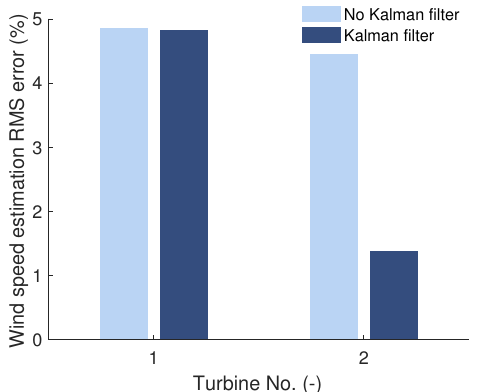
Figure 5. Root-mean-square (RMS) deviation of rotor effective wind speed estimation at turbines of two-turbine array. RMS deviation is normalized with mean freestream wind